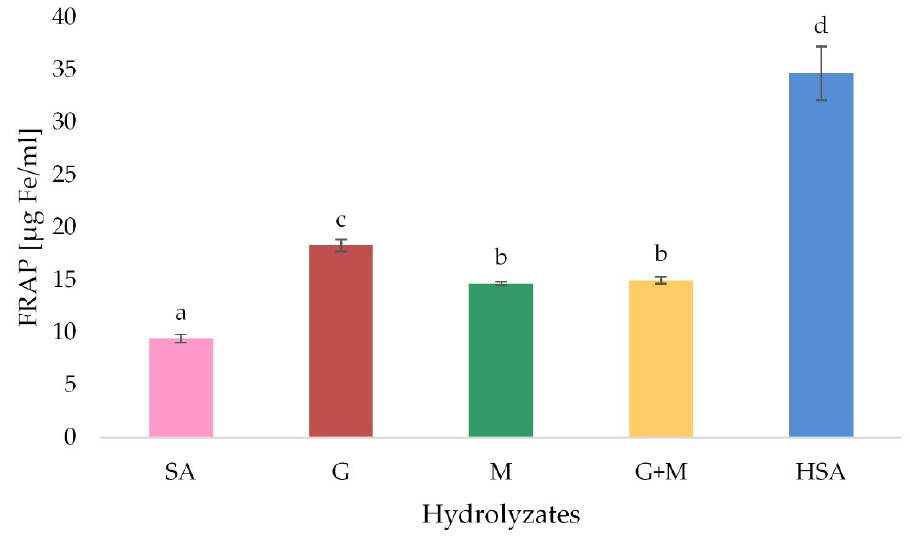
Figure 4. Ferric reducing antioxidant power of acidic (G, M and M + G) and oxidation (HSA) depolymerization products of sodium alginate-control (SA). Results are expressed as the mean ± standard error. Values with different letters ( a – d ) within the same column differ significantly ( p < 0.05) .